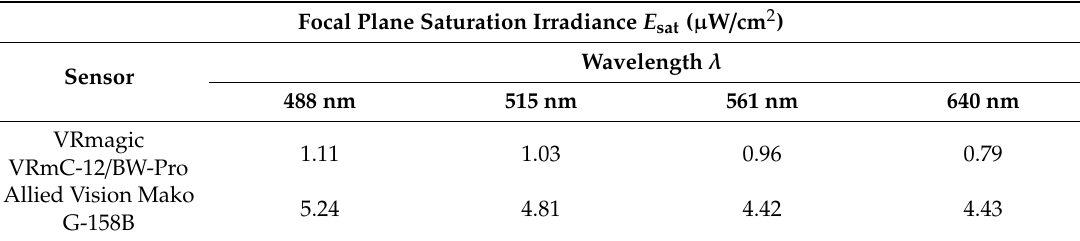
Table 6. Focal plane saturation irradiance calculated according to Equation